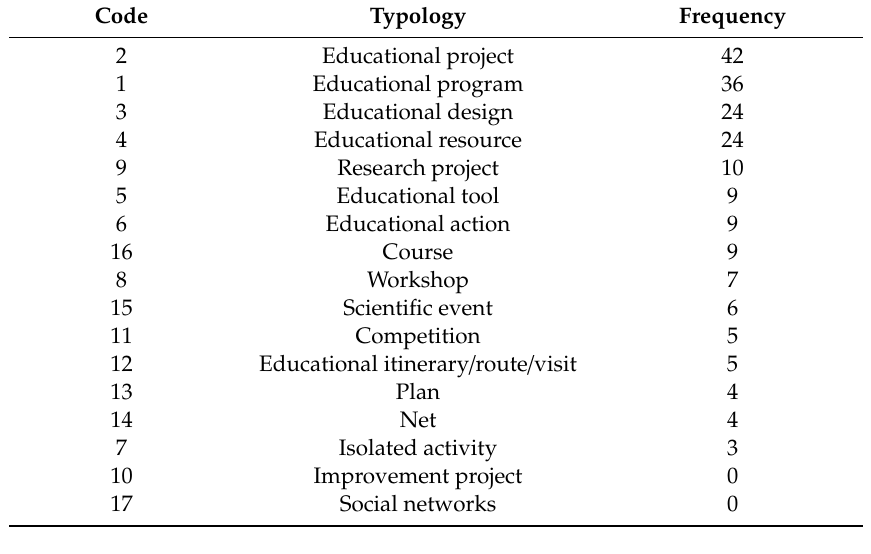
Table 5. Frequencies obtained according to typology of educational design.